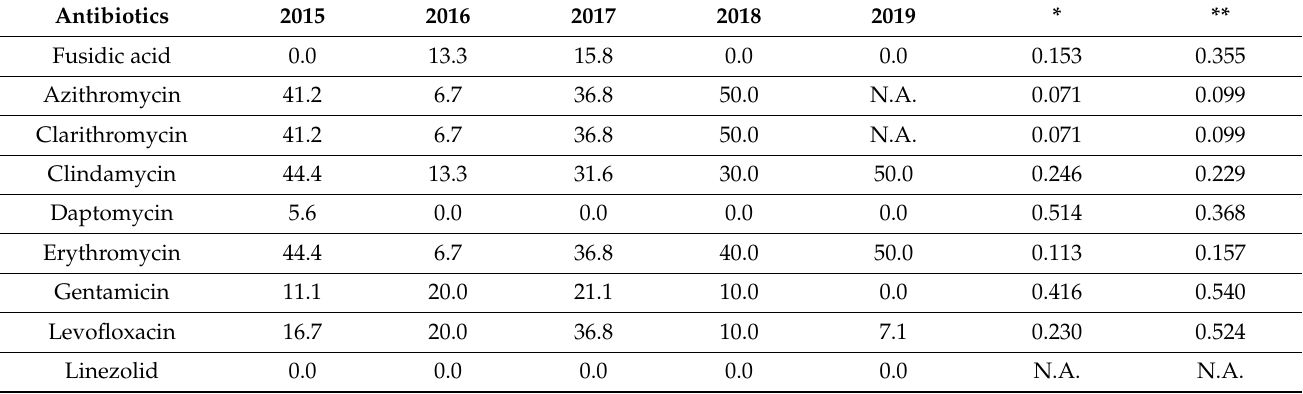
Table 4. Resistance rates (%) of Staphylococcus aureus isolated from ocular samples by year.